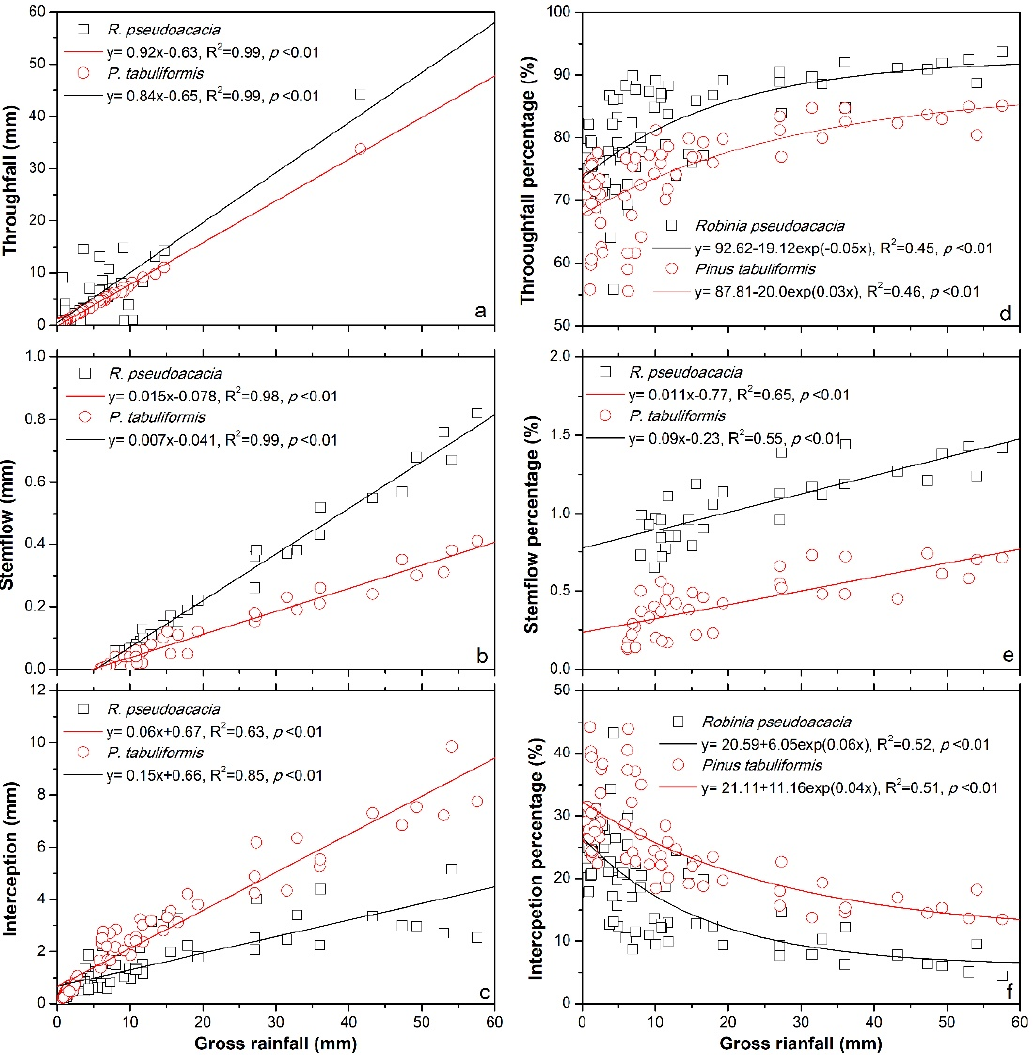
Figure 2. Relationships between individual rainfall amounts and rainfall partitioning components for R. pseudoacacia ( a – c ) and P. tabuliformis ( d – f ) during the growing season of May–October in 2015 and 2016.